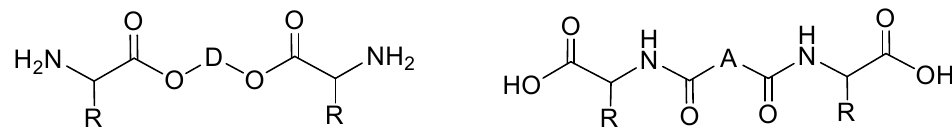
Bis-(amino acid)-alkylene diesters, AAAD N , N '-diacyl-bis-amino acid, DABA